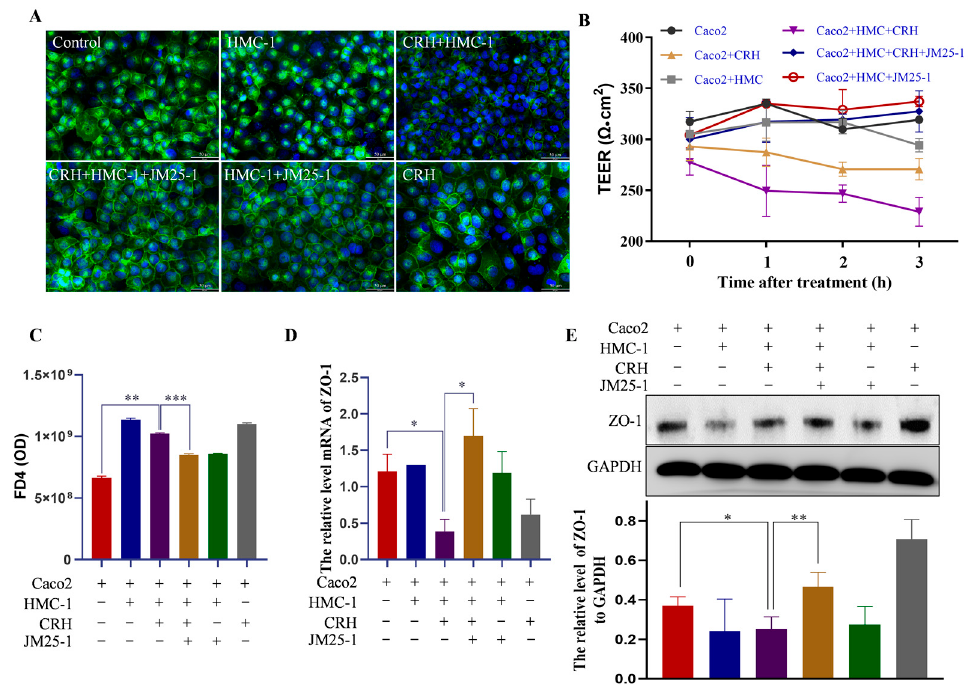
Figure 3. JM25-1 reduces the paracellular permeability of Caco2 cells via HMC-1 cells. HMC-1 cells were co-cultured with Caco2 that established a differentiated and polarized monolayer. JM25-1 were pretreated in HMC-1 for 30 min and then CRH stimulated for 24 h. The TJ were performed with ( A ) immunofluorescence staining of ZO-1; bar = 50 µ m, magnification 400 × ; ( D ) mRNA of ZO-1; ( E ) protein level of ZO-1 in Caco2 cells monolayers. For detection of paracellular permeability, ( B ) transepithelial electrical resistance (TEER) at 0 h was measured before CRH treatment. After CRH treatment, TEER was monitored per hour until the trend is stable at 3 h; then, ( C ) the flux of FITC-dextran was examined; Bars, S.D. * p ≤ 0.05, ** p ≤ 0.01, *** p ≤ 0.001. n = 3 from three independent experiments.